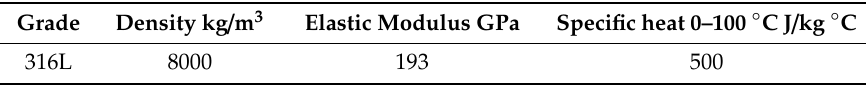
Table 3. Physical properties of 316L grade stainless steel